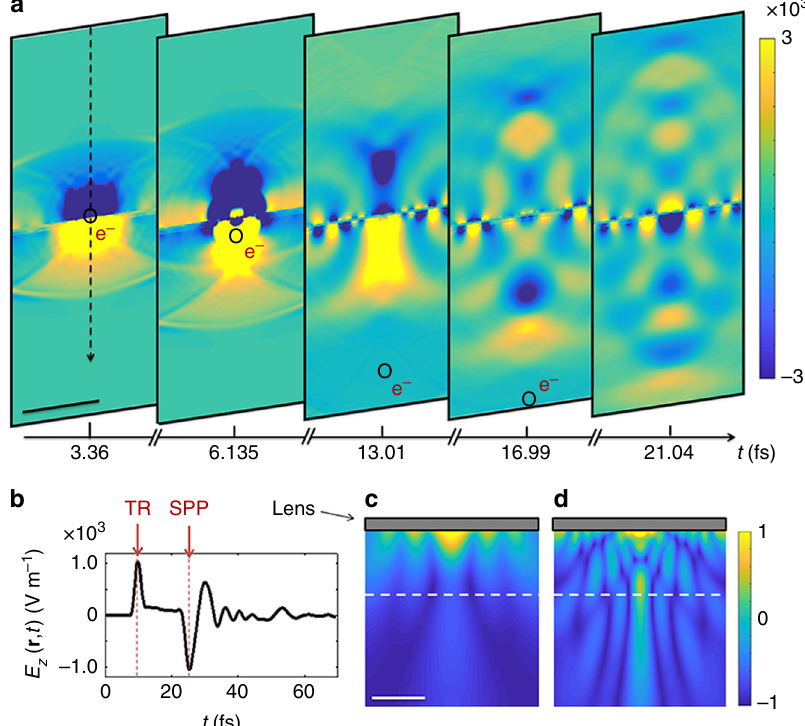
Fig. 3 Simulated spatio-temporal response of the planar lens interacting with a 30 keV electron. a Snapshots of the z -component of the electric fi eld amplitude at depicted times for the indicated electron positions, which demonstrate that the electromagnetic wave packet is focused into a 1.5 µ m waist at 5.7 µ m distance from the structure (see Supplementary Movie 1). Color bar is the electric fi eld amplitude at the dimensions of V m − 1 . Scale bar is 5 μ m. b Temporal representation of the z-component of the electric fi eld at the focal point. Fourier transform of the temporal data, giving the z -component of the electric fi eld at the c E = 0.6 eV and d E = 1.4 eV. The white dashed line marks the focal plane. TR stands for transition radiation. Color bar is the averaged electric fi eld magnitude at arbitrary units. Scale bar is 4 μ